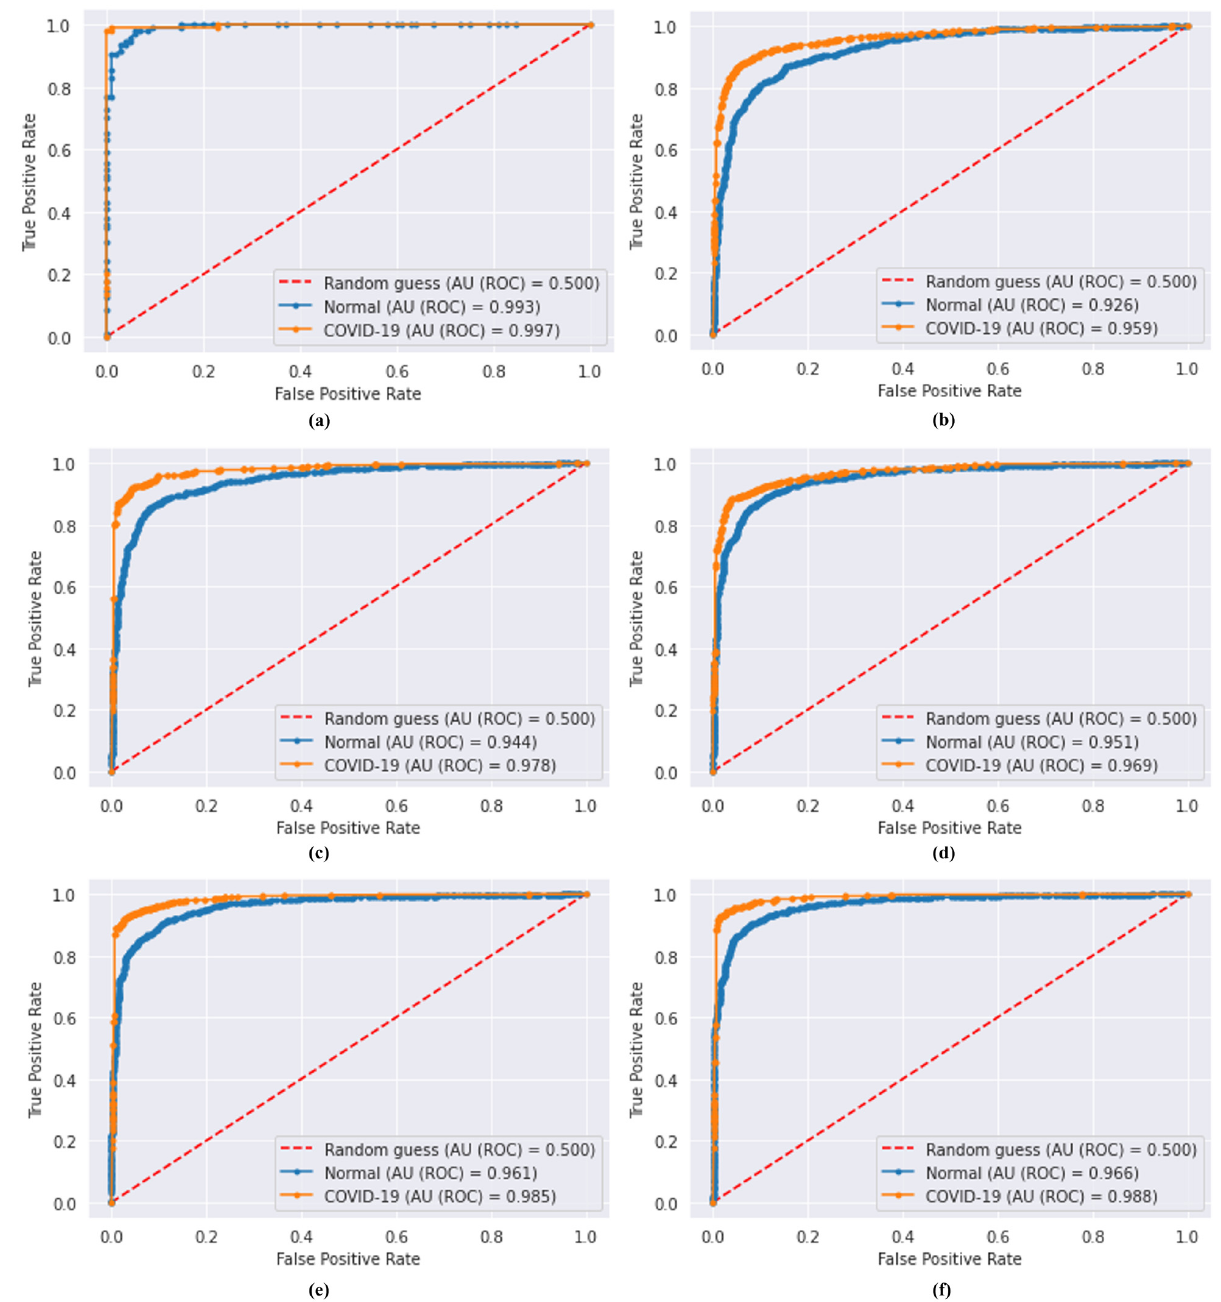
Figure 7. AU(ROC) curves; ( a ) proposed model, ( b ) VGG-16, ( c ) VGG-19, ( d ) ResNet-101, ( e ) DenseNet-169, and ( f ) DenseNet-201. Table 5. Comparison of the proposed model with UNET and UNET++ for the segmentation